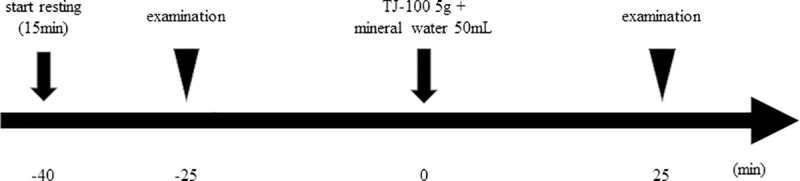
Outline of the study.The subjects were examined after ≥2-hour fasting. After 15 min of rest, the first examination was performed. After 25 min, 5.0 g of TJ-100 and 50 ml of mineral water were administered orally followed by 25 min of rest by the subject, and then the secondary examination was performed. All participants underwent both DUS and PC-VIPR within 4 weeks, with a minimum interval of 1 week.